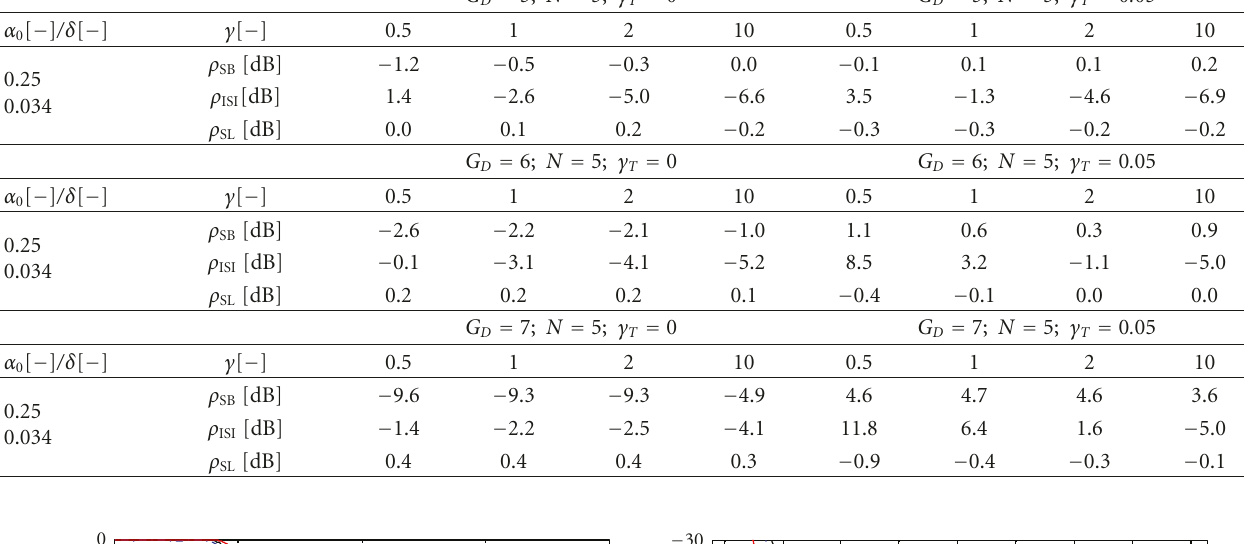
Table 4: Numerical values of ρ SB [dB], ρ ISI [dB], ρ SL [dB]. Square root Nyquist ( M ) filter versus square root Nyquist δ -filter. The N parameter is fixed and the group delay parameter G D of the filter varies; γ and γ T are the design parameters of the iteration algorithm [19]. Square Root Nyquist ( M )/Square Root Nyquist δ -filter